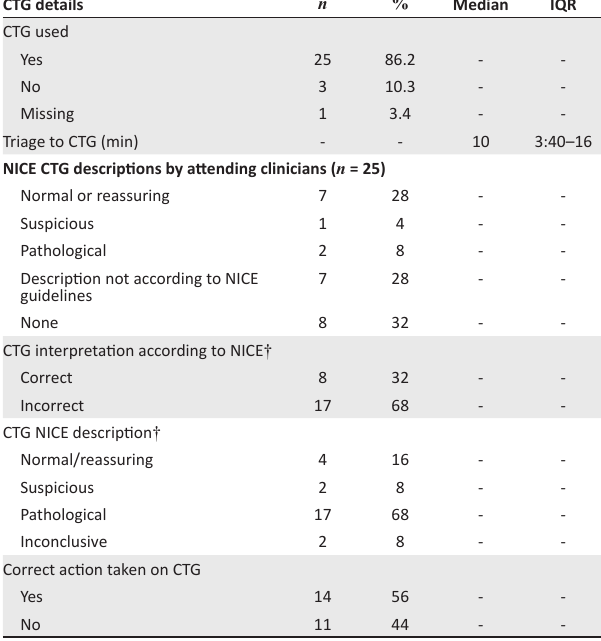
TABLE 3: Cardiotocogram characteristics.